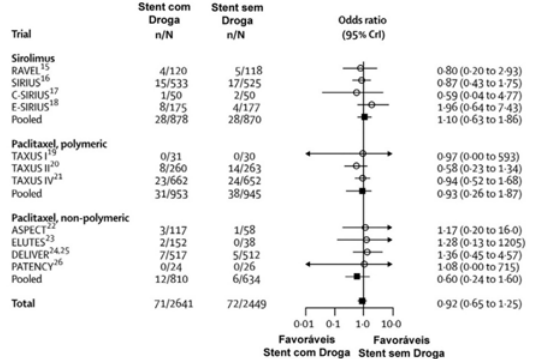
Fig. 3 - Metanálise (Forest plot) de Trials sobre infarto do miocárdio comparando “Stent” com droga x “Stent sem droga. Não há diferença - Guyton, 2006 [2]